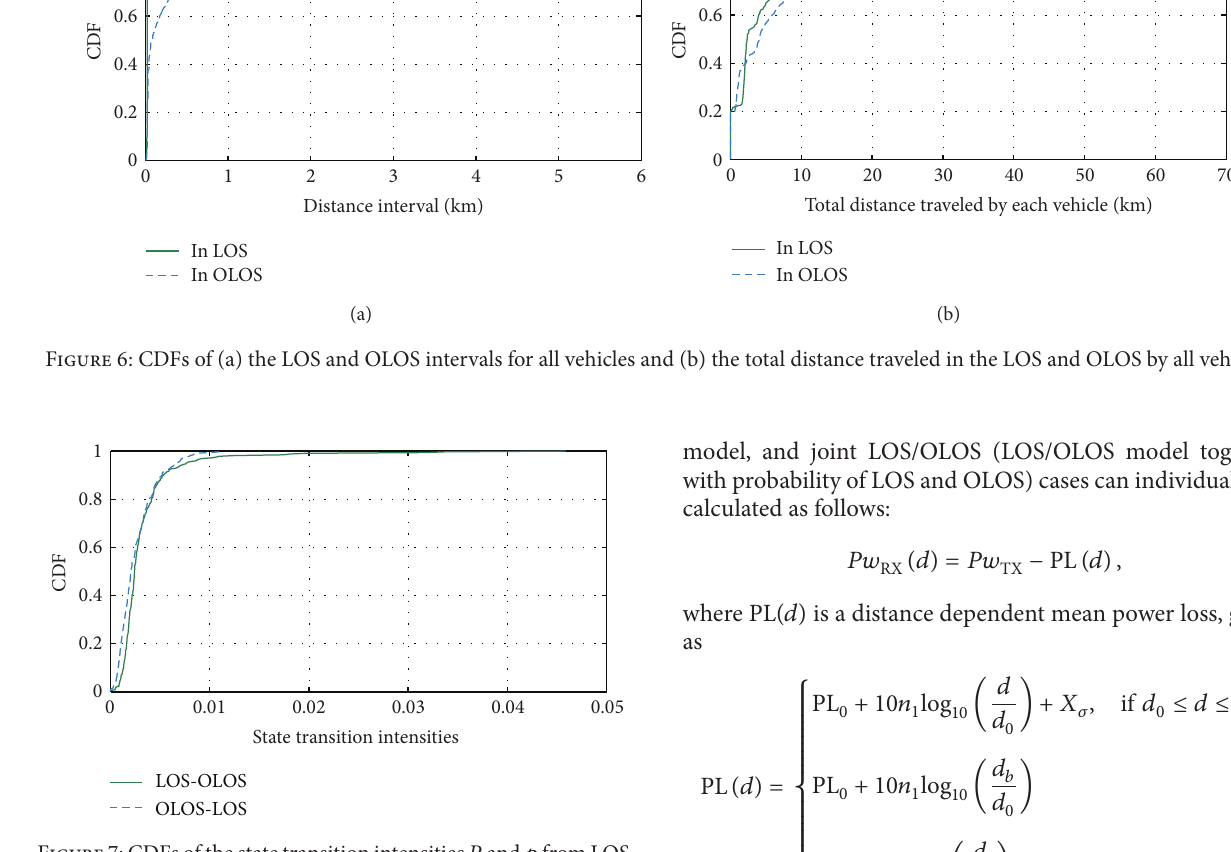
Figure 7: CDFs of the state transition intensities 𝑃 and 𝑝 from LOS- OLOS and OLOS-LOS, for each vehicle, respectively.